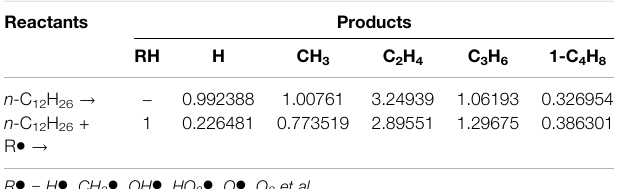
TABLE 2 | The seven-reaction simpli fi ed fuel-decomposition model of n -dodecane. Reactants